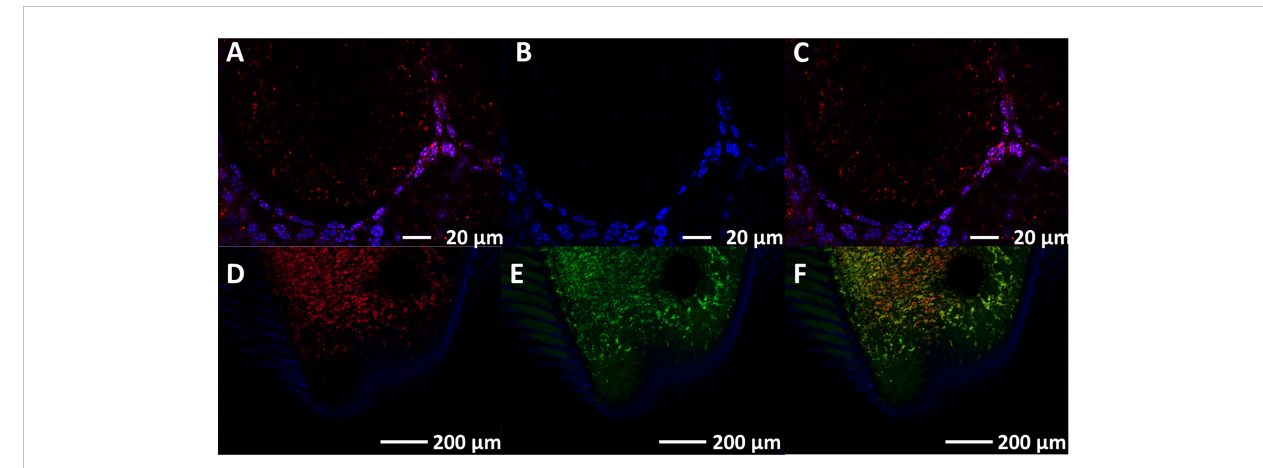
FIGURE 3 VgP circulates through the hemolymph, reaches the ovary and is speci fi cally internalized into the oocytes. In vivo injection of both VgP-TAMRA and ScVgP-FITC peptides shows directed delivery of VgP to the oocytes. Fluorescence images of oocytes and gills were taken from an early vitellogenic female injected simultaneously with VgP-TAMRA and ScVgP-FITC. Confocal images of the accessory cells surrounding the oocytes (Hoechst, blue), (A) VgP-TAMRA (red dots), (B) ScVgP-FITC. (C) the overlay of images (A, B) Both VgP-TAMRA and ScVgP-FITC were detected in the gills (D , E ), respectively ) . (F) overlaid images of (D , E)